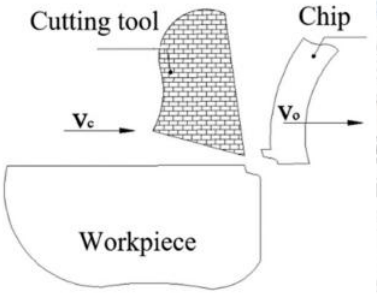
Figure 4. An imprint of cutting wedge on the chip at the interrupted cut.